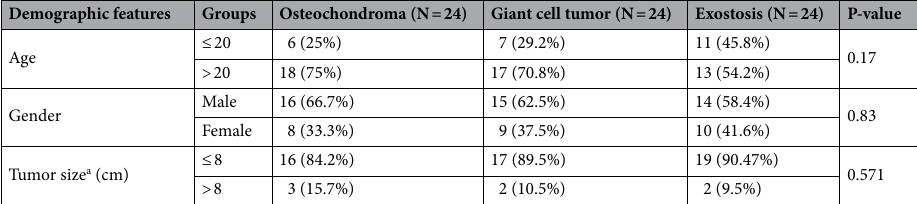
Table 2. The clinic- pathological features of patients with benign bone tumors. a Number of patients with available